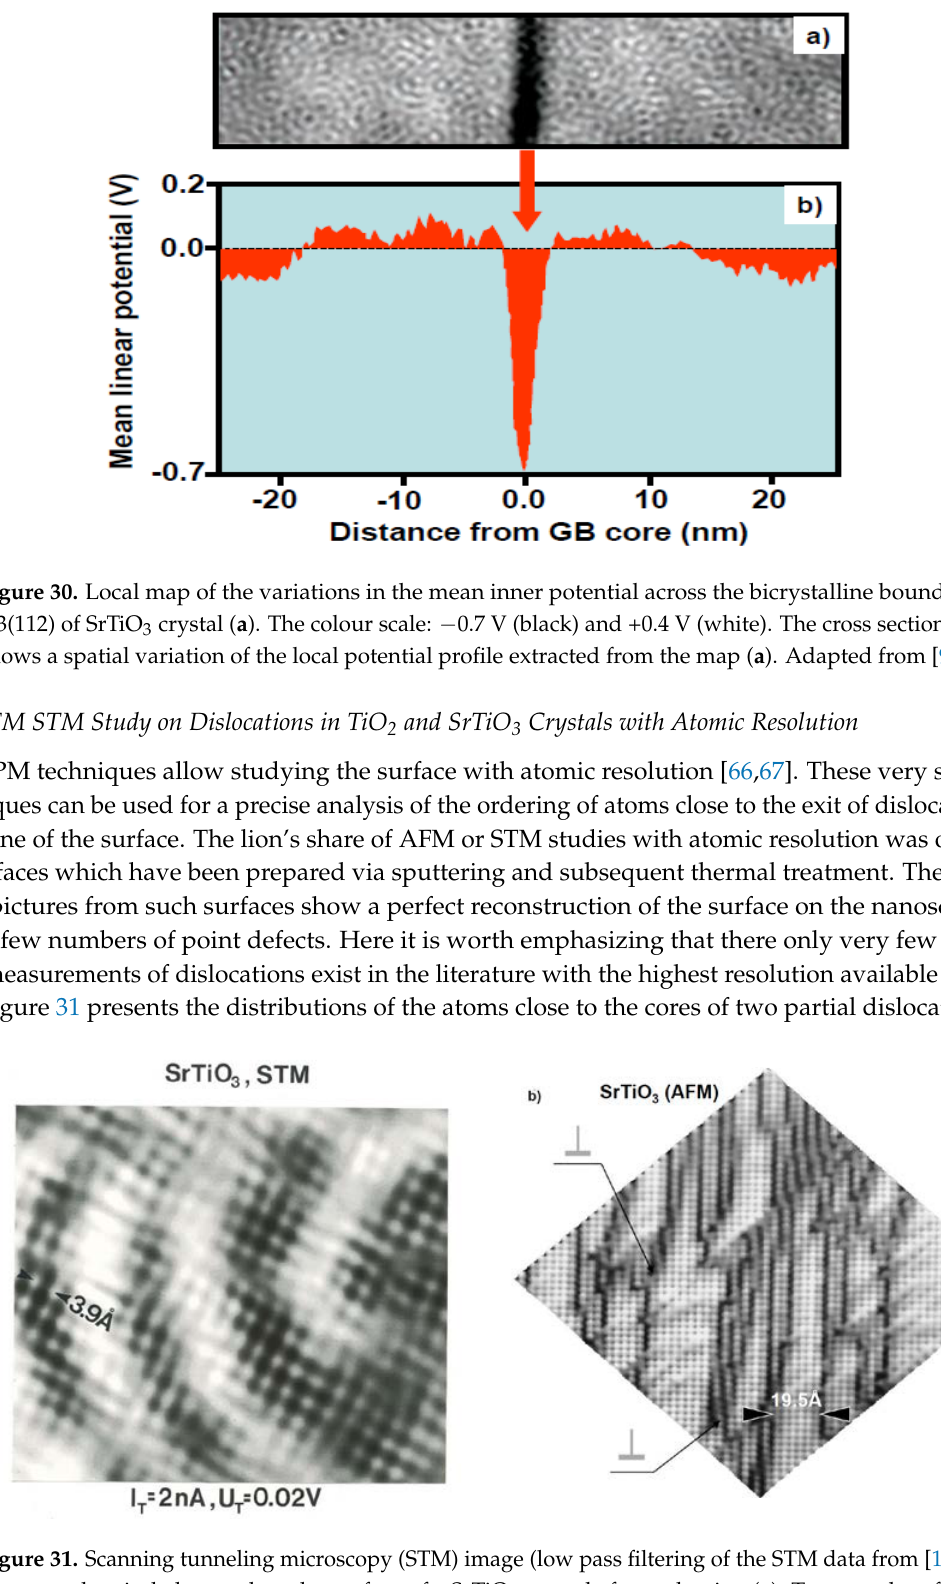
Figure 31. Scanning tunneling microscopy (STM) image (low pass filtering of the STM data from [120]) of a growth spiral observed on the surface of a SrTiO 3 crystal after reduction ( a ). Topography of the surface of an oxidized SrTiO 3 crystal, obtained using AFM, shows the two exits of the dislocations ( b ), adapted from [68].